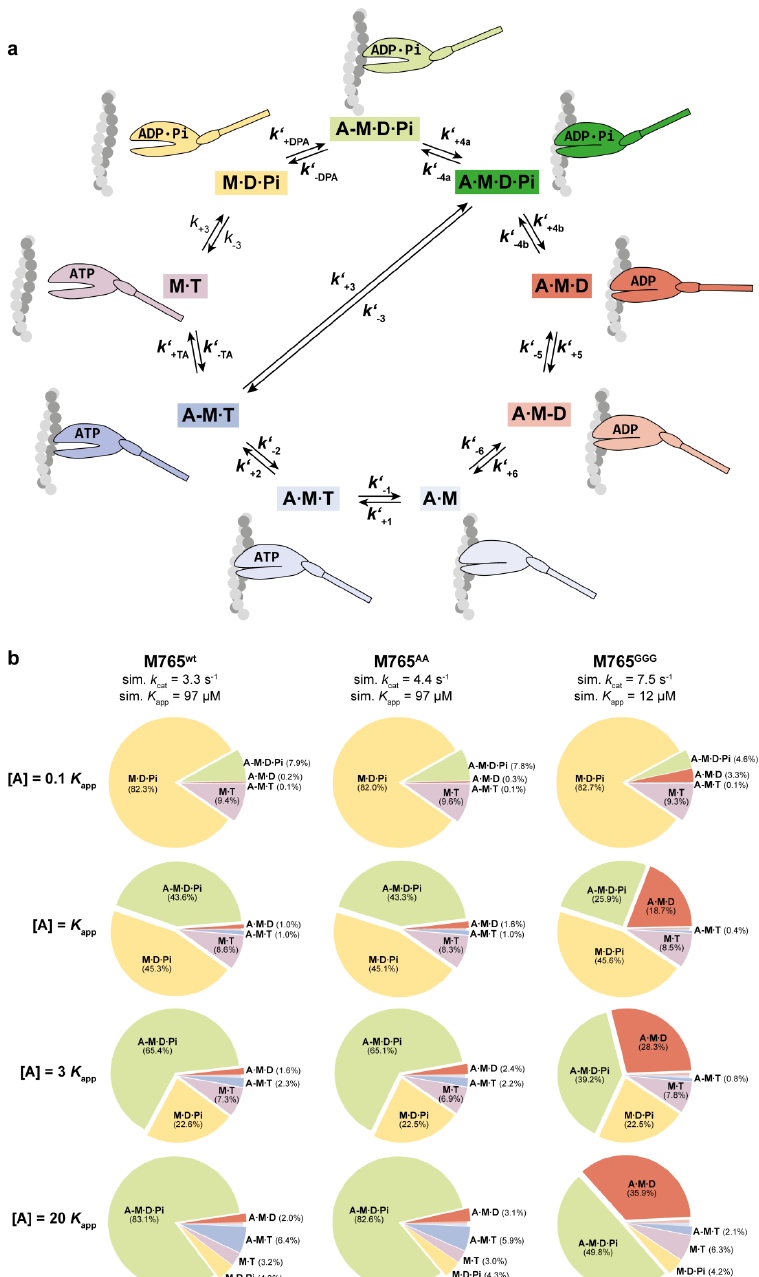
Figure 7. The actomyosin cross-bridge cycle and its major intermediate states. ( a ) A minimal, (9+1)–step model of the actomyosin ATPase cycle, which includes the start-of-power-stroke state (A · M · D · P i highlighted in green). Notations are the same as in Figure 2a. Structural states of myosin with weak actin affinity are depicted as globular heads with an open actin-binding cleft. Strongly actin-attached states are depicted with a closed actin-binding cleft, and detached states without contacting actin. Strongly actin-bound states (A · M, A · M · T, A · M · D · P i , A · M · D, A · M-D), weakly actin-bound states (A-M · T, A-M · D · P i ) and detached states (M · T, M · D · P i ). ( b ) Pie chart illustration of the fractional occupancies of the ATPase cycle intermediates at different actin concentrations (0.1K app , 1K app , 3K app and 20K app ) for wildtype and mutants as obtained by modeling using the MUSICO program [59]. Modeling is based on experimentally determined parameters and complemented by estimated values as summarized in Table 5. The relative occupancy of the accessible intermediate states is shown as a percentile in the pie charts. The percentiles of the short-lived intermediates A · M · T, A · M, and A · M-D range for all constructs between 0.04% and